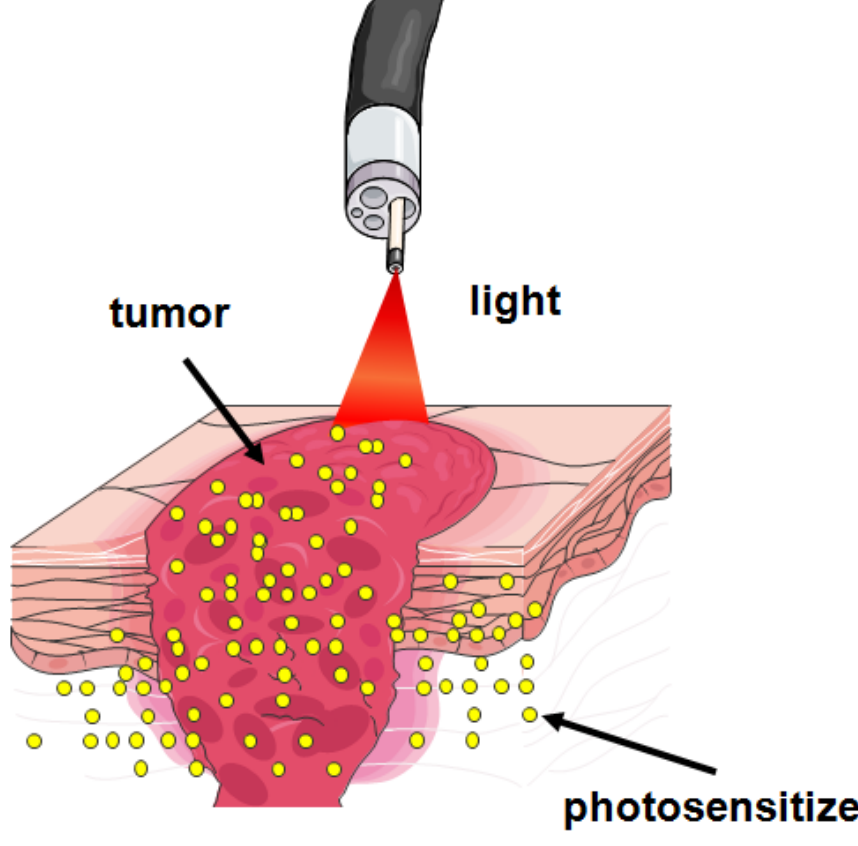
Figure 1. Overview of PDT. Following photosensitizer administration it undergoes systemic distribution and selectively accumulates in the tumor. Illumination activates the photosensitizer and in the presence of molecular oxygen triggers a photochemical reaction that culminates in the production of 1 O 2